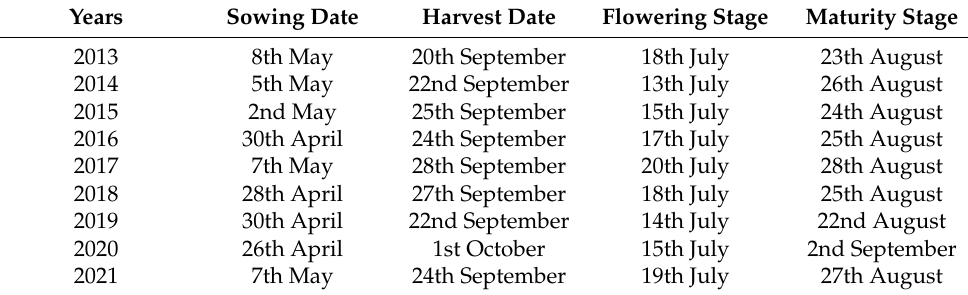
Table 4. Maize sowing, harvesting, and sampling